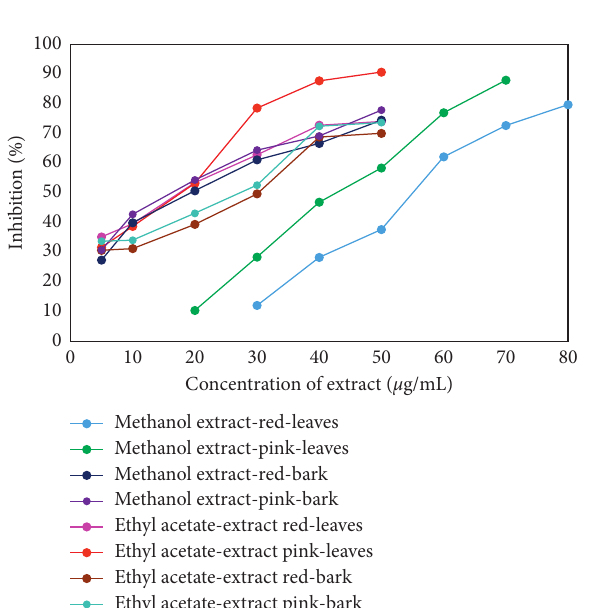
Figure 3: Antioxidant activities of various concentrations of S. aqueum leaves and stem bark extracts to hydrogen peroxide.